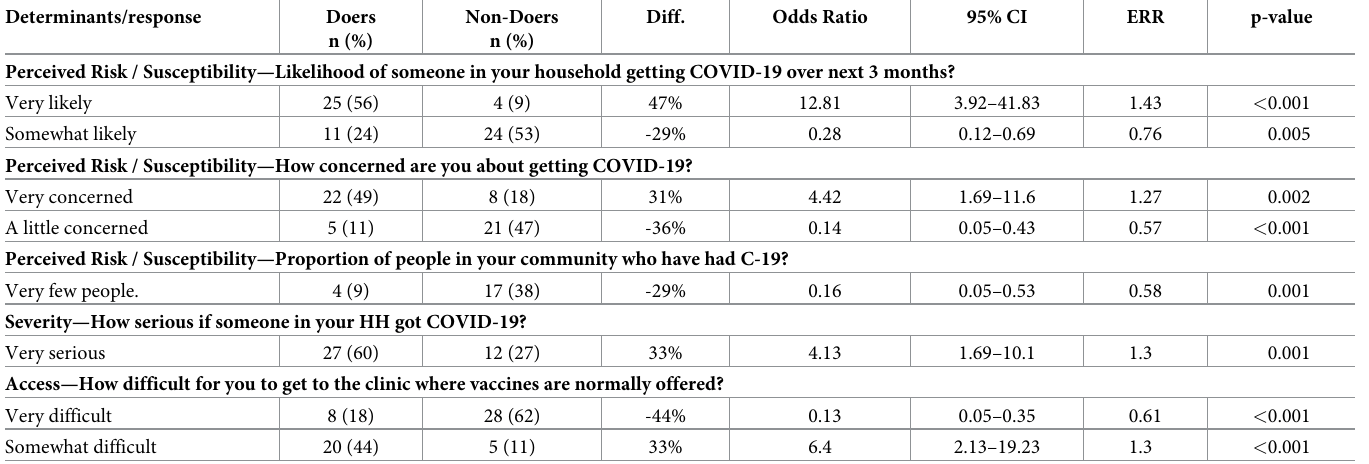
Table 7. Perceived risk/susceptibility to COVID-19, perceived severity of COVID-19, and perceived access.